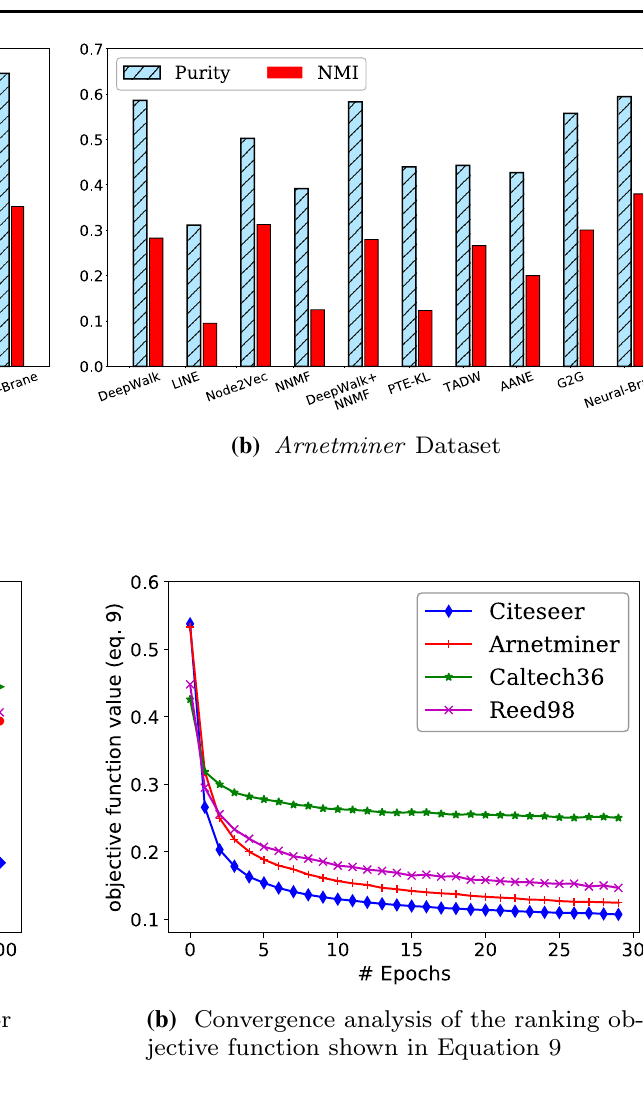
Fig. 5 Analysis of the embedding dimension and